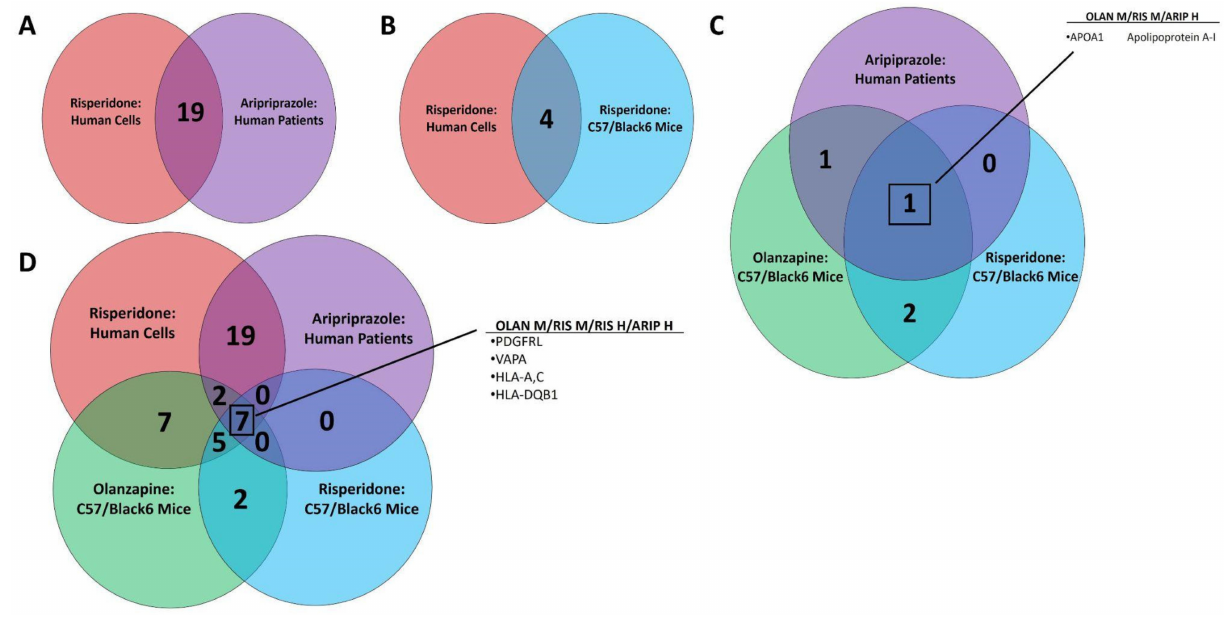
Figure 3. Common Iron-Associated Differentially Expressed Traits. Venn diagrams representing overlap in DE traits related to iron homeostasis between AA-exposed multi-omic data sets were generated. Transcriptomic changes in psychiatric patients treated with ARIP are shown in pink, and in human neuroblastoma cells exposed to RIS are shown in purple. Proteomic changes in non-obese mice treated with OLAN are shown in green, and in non-obese mice treated with RIS are shown in blue. Common changes in human systems in vitro or in vivo are shown, ( A ) as are common changes induced by RIS in vitro and in vivo. ( B ) The number of changes seen in vivo that are not seen in vitro are shown. ( C ) DE traits common across study systems are shown in Panel ( D ), and the most critical traits are noted.